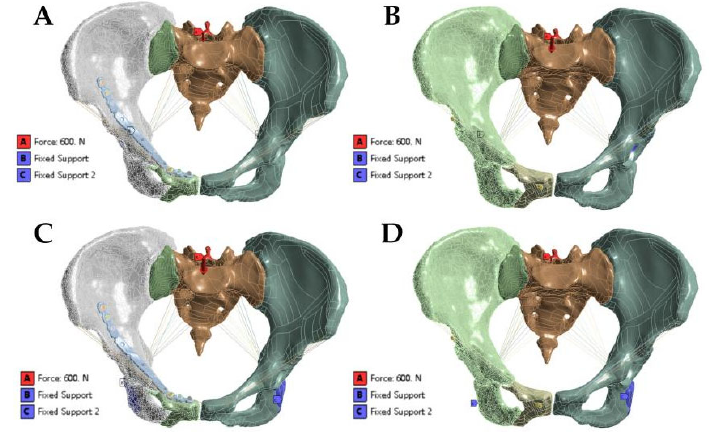
Figure 2. ( A , B ) Loads and boundary conditions of anterior ring plate group and anterior ring hollow screw group in standing position. ( C , D ) Loads and boundary conditions of anterior ring plate group and anterior ring hollow screw group in sitting position.